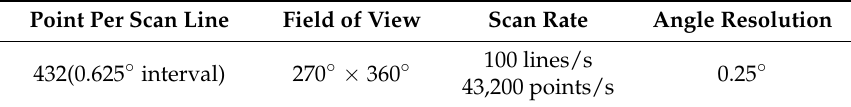
Table 2. Technical characteristics of the ZEB-REVO according to the manufacturer